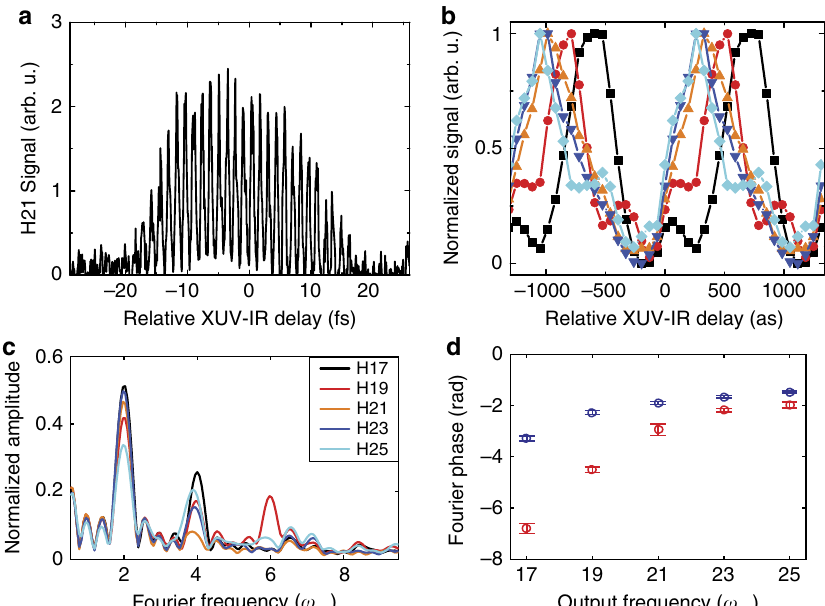
Fig. 2 Spectral analysis of multi-quantum-path beating in XUV-initiated HHG. a Intensity of harmonic 21 as function of the relative XUV-IR delay. Zero delay is de fi ned arbitrarily. b Intensity of harmonics 17 – 25 as a function of the relative XUV-IR delay. All harmonics oscillate with a dominant frequency of 2 ω IR and peak at different delays in a descending order. For better visibility, the signal is integrated over seven oscillation cycles, normalized and displayed over several cycles. The different harmonics are represented by colors as in c . c Fourier analysis of the oscillating signal of harmonics 17 – 25. Strong anharmonic components at 4 ω IR are visible, as well as signatures of 6 ω IR oscillations. d Measured Fourier phases (circles) as a function of harmonic order at Fourier frequencies of 2 ω IR and 4 ω IR , in blue and red, respectively (error bars: standard deviation; for details, refer to Methods